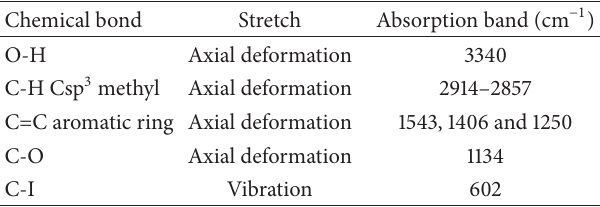
Figure 1: FTIR spectrum of 4-iodo-2,5-dimethylphenol. with sodium hypochlorite which causes the 3I − /I 3− complex to remain in its oxidized form, I 3− .